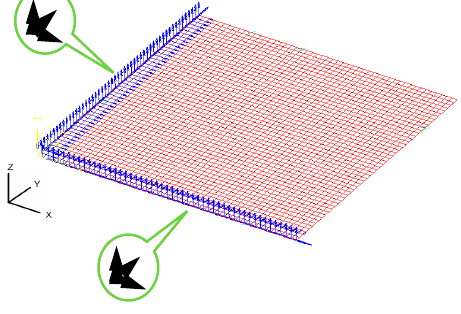
Figure 4. Boundary conditions of blank.